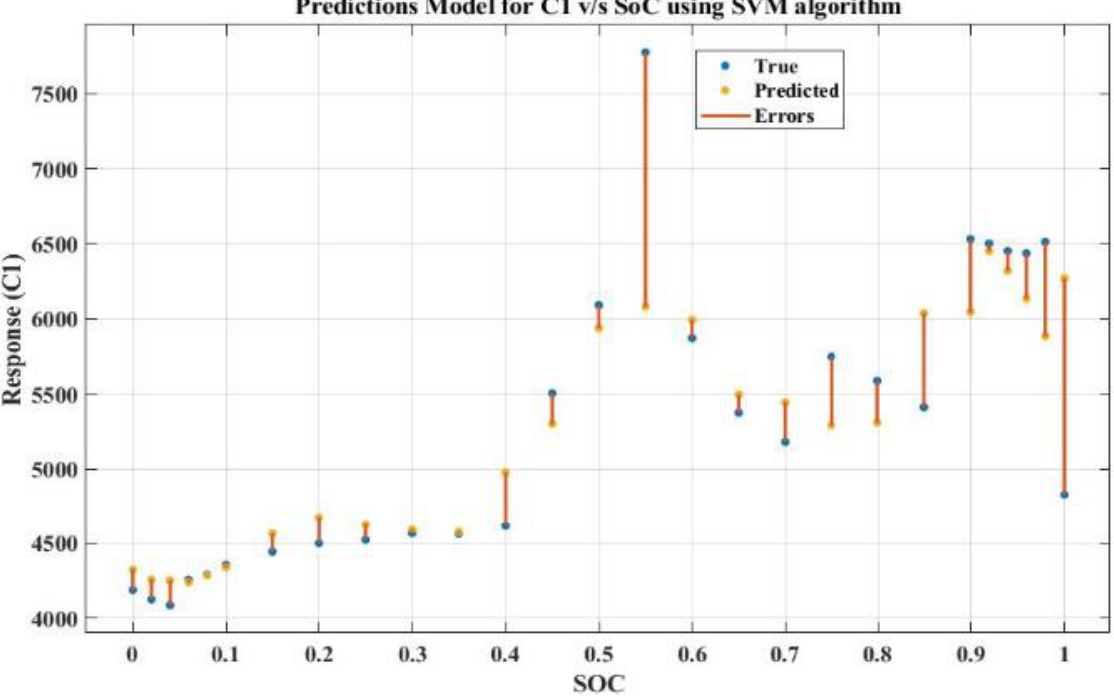
Figure 20. Prediction model for parameter estimation: C 1 vs. SOC.